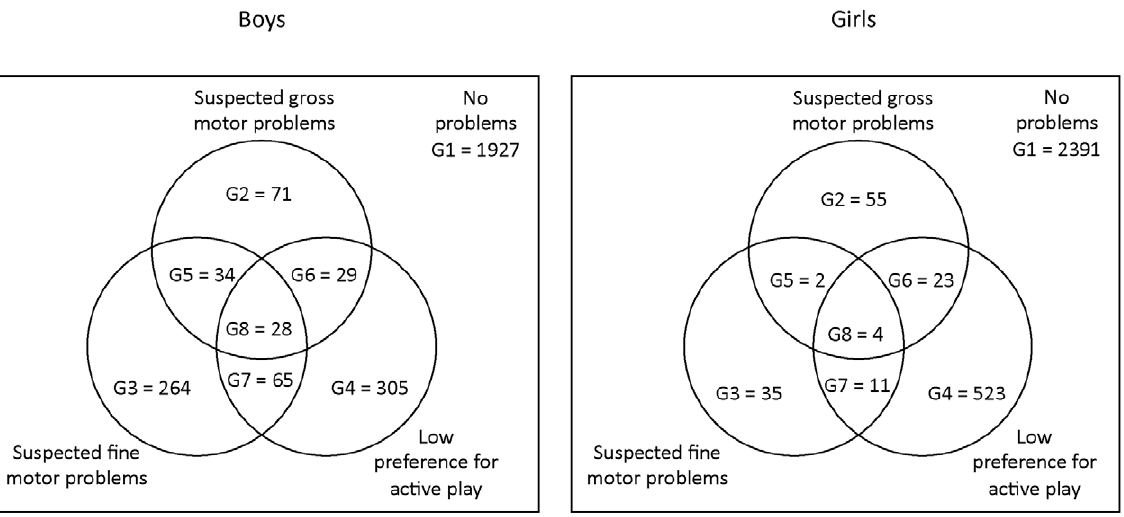
Figure 1. The number of boys (N=2723) and girls (N=3044) belonging to each subgroup according to suspected gross and fine motor problems and low preference for active play at age 8 years. Areas are non-proportional.